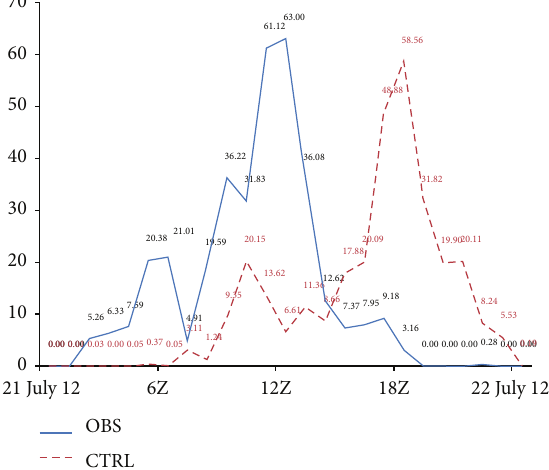
Figure 5: Time series of observation (solid) and CTRL (dash) at Fangshan (115.98 ∘ E, 39.72 ∘